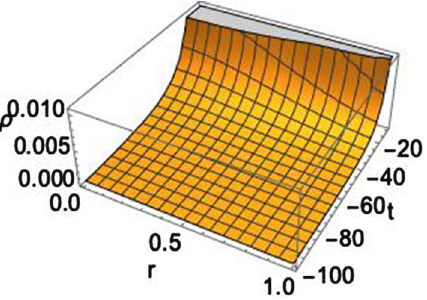
Fig. 4 Massprofileasafunctionoftheradialandtemporalcoordinates